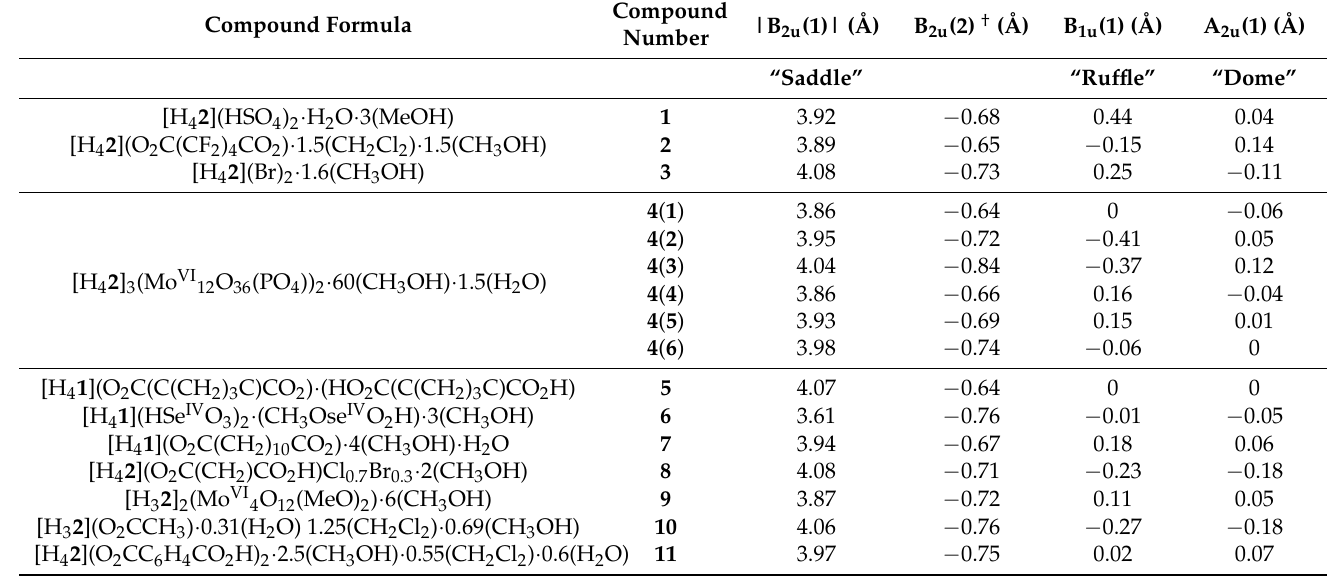
Table 3. The prominent out-of-plane NSD values for the structures discussed in this paper. † B 2u (2) modes are relative to B 2u (1)